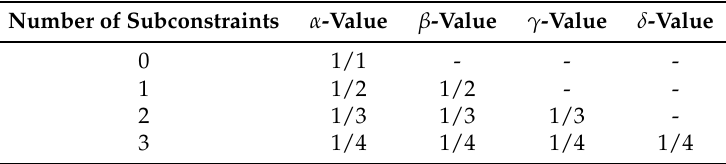
Table 3. Weights in models with different numbers of constraints.